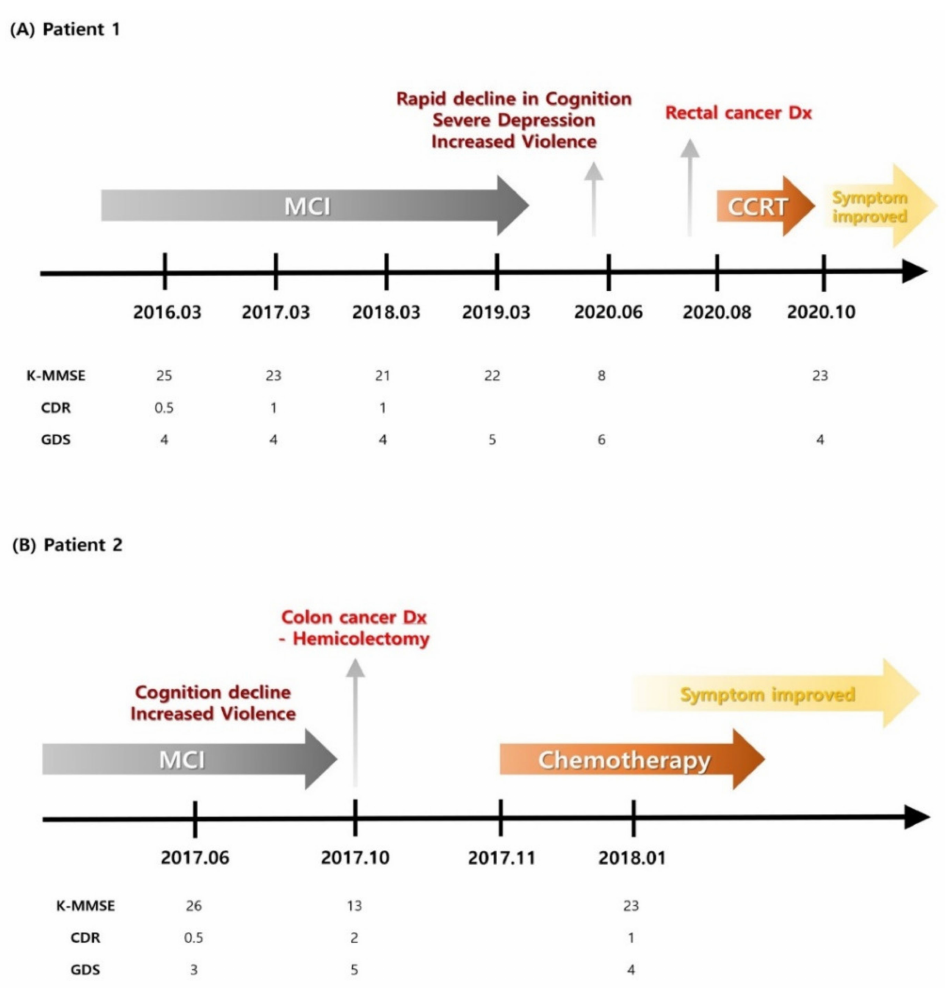
Figure 1. Patients’ timelines. CCRT—concomitant chemoradiation therapy; CDR—clinical dementia rating; Dx—diagnosis; GDS—global deterioration scale; K-MMSE—Korean Mini Mental-Status Examination; MCI—mild cognitive